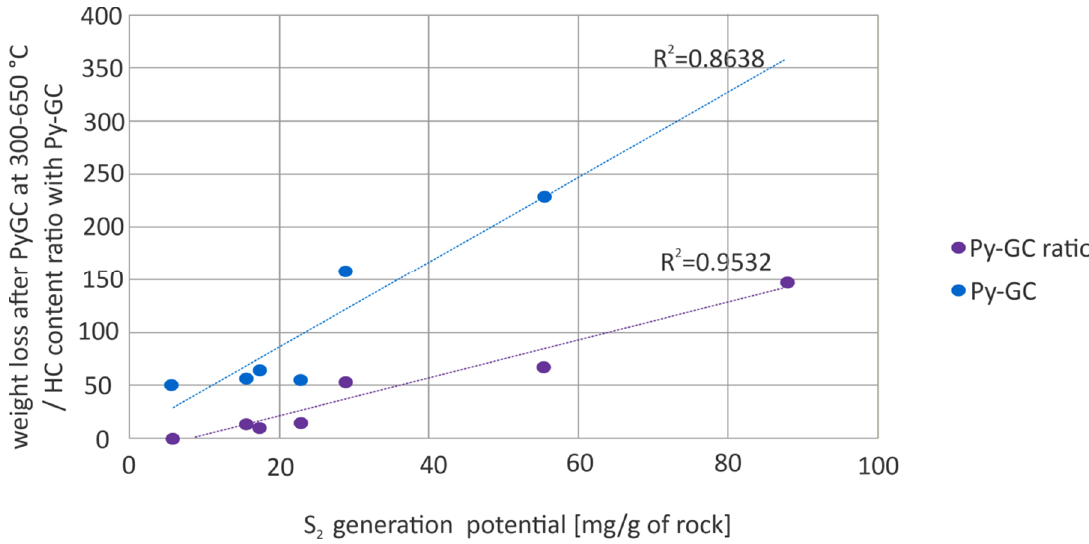
Figure 12. Correlation between the S 2 generation potential and Py/GC pyrolysis parameters in the temperature range of 300–650 °C for Menilite samples.